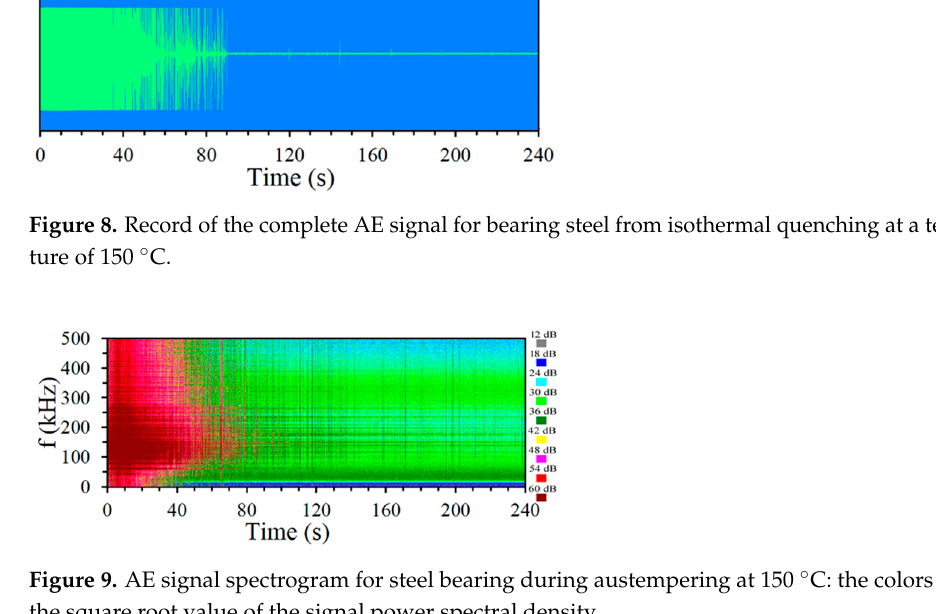
Figure 8. Record of the complete AE signal for bearing steel from isothermal quenching at a tem- perature of 150 °C.